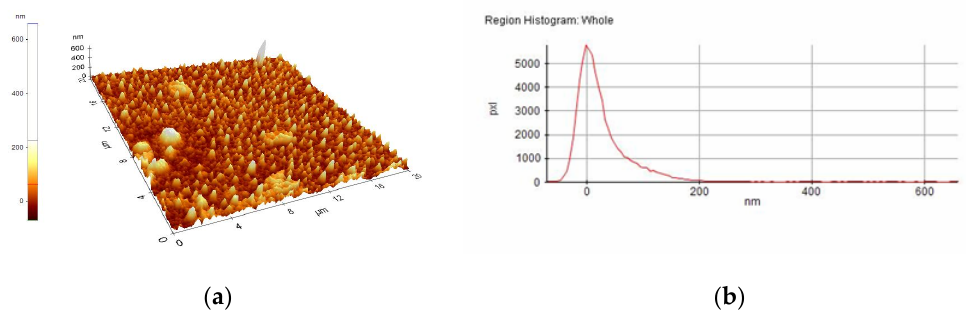
Figure 5. AFM image of 1%rGO-SiO 2 -P 2 O 5 /ITO film: ( a ) morphology, ( b ) region histogram